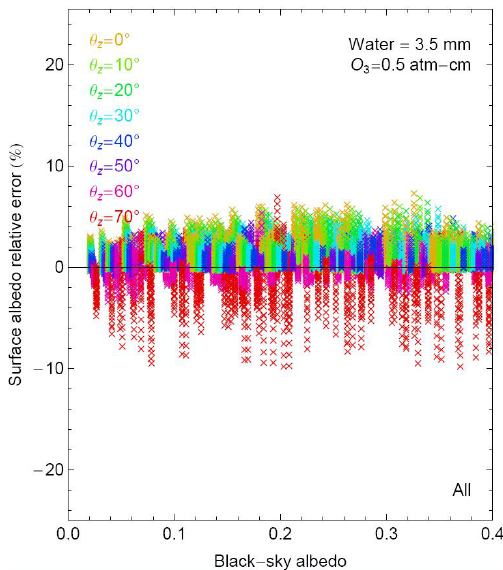
Fig. 12. The relative difference in albedo retrieval, resulting from using a constant AOD of 0.1 versus true AOD (up to 0.4) for a range of surface spectra and sun zenith angles. Results shown as a function of true black-sky albedo of the terrain.